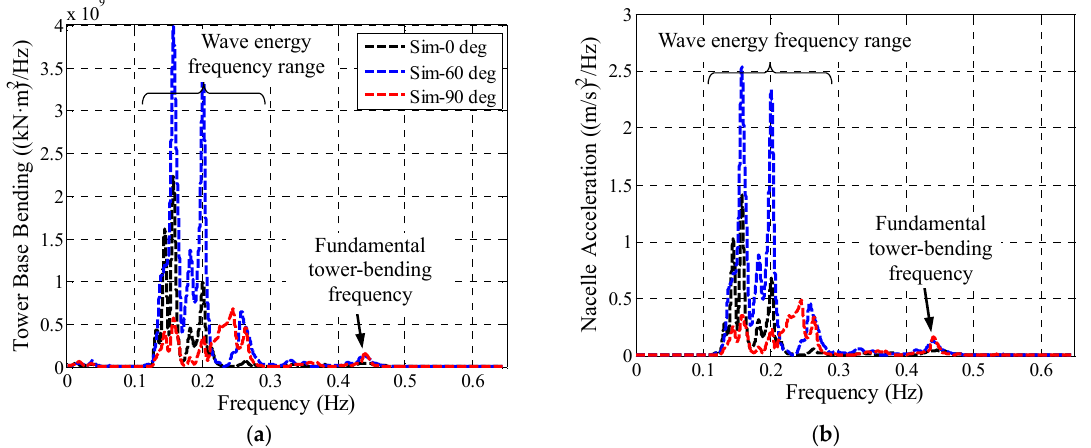
Figure 24. Comparisons of ( a ) tower base fore-aft bending and ( b ) nacelle acceleration PSD between three aligned wind and wave directions.